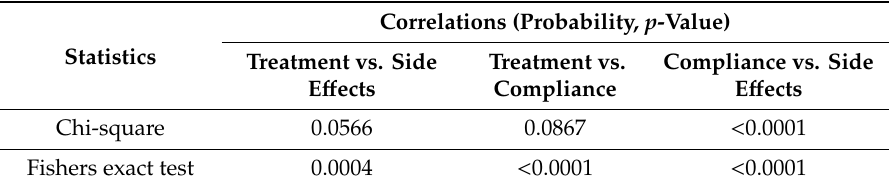
Table 3. Correlation between treatment, compliance and side e ff ects.